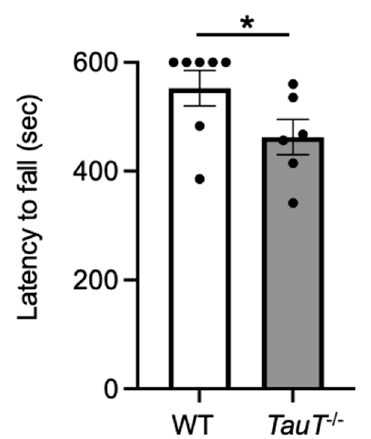
Figure 2. Muscular endurance was reduced in TauT − / − mice. Wire-hang test was performed. Average latency to fall from the wire mesh of two trials in WT and TauT − / − mice. * p < 0.05 by Mann-Whitney test. Error bars represent S.E.M. Closed circles represent animals.